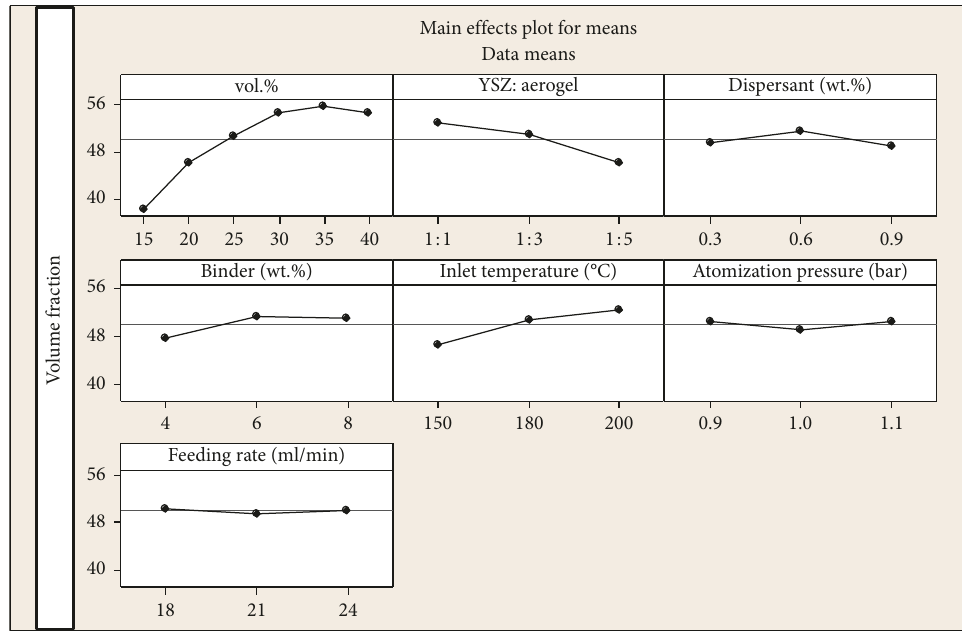
Figure 2: Effect of slurry formulation and granulation variables on volume fraction of YSZ-aerogel spray-dried